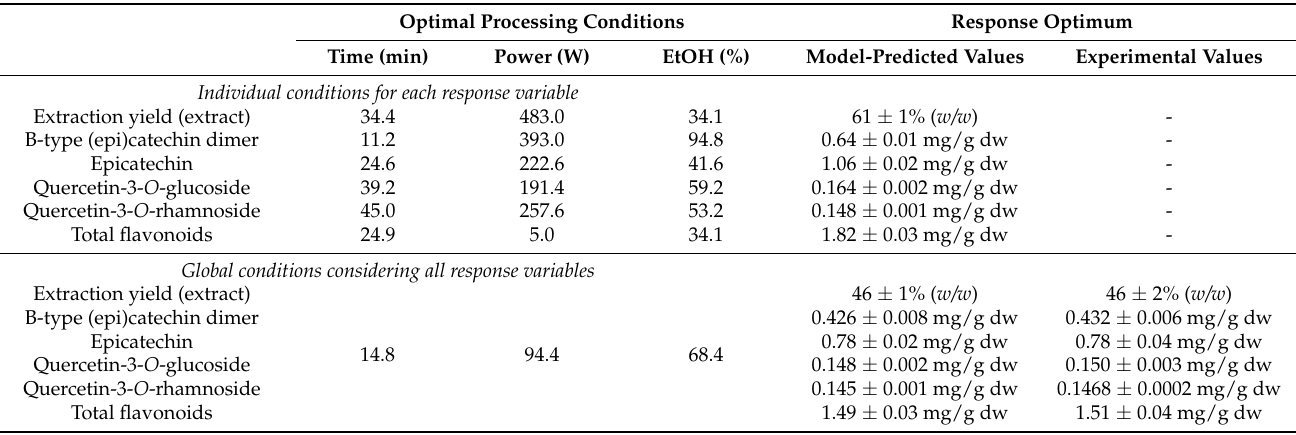
Table 3. Optimal processing conditions that maximize the extraction of flavonoids from kiwi peel and model-predicted and experimental response optimum.